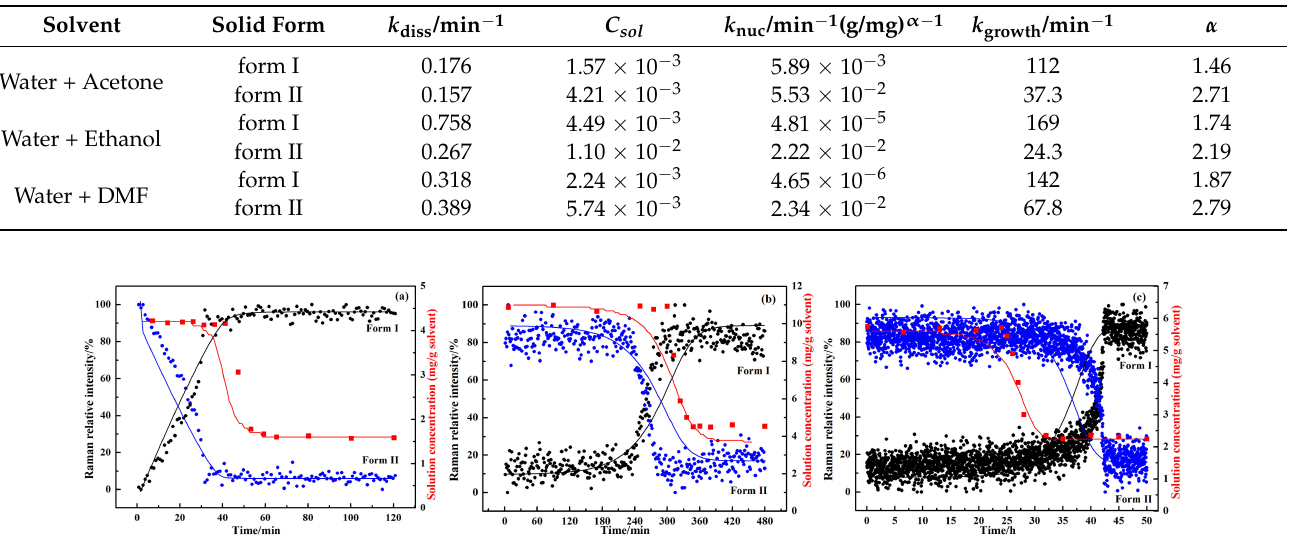
Figure 11. Calculated solid composition profiles and solution concentration profile during the solution-mediated polymorphic transformation from form II to form I of L-carnosine in different solvent mixtures: ( a ) water + acetone; ( b ) water + ethanol; ( c ) water +